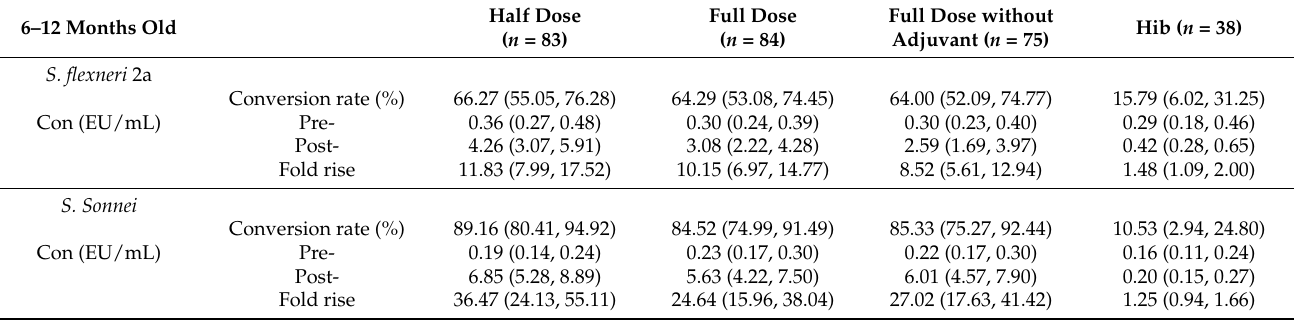
Table 3. Immunological response for children aged 6–12 months old with different vaccines.